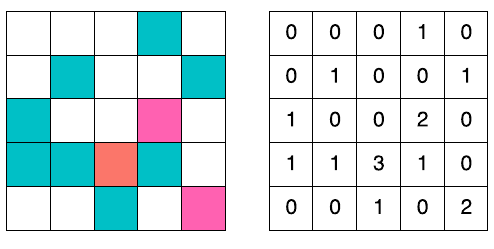
Figure 3. Lattice